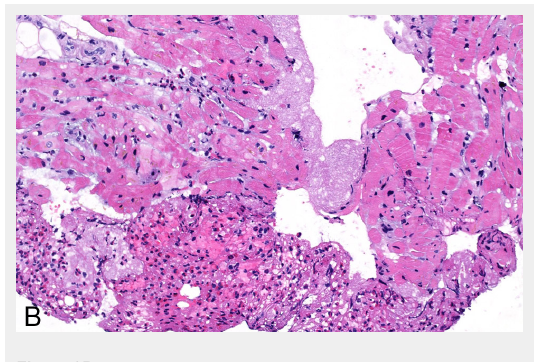
Intramyocardic vessels showing luminal eosinophils which were also found in the surroundig interstitium and between the myocardial fibers (H&E stain, 100x).